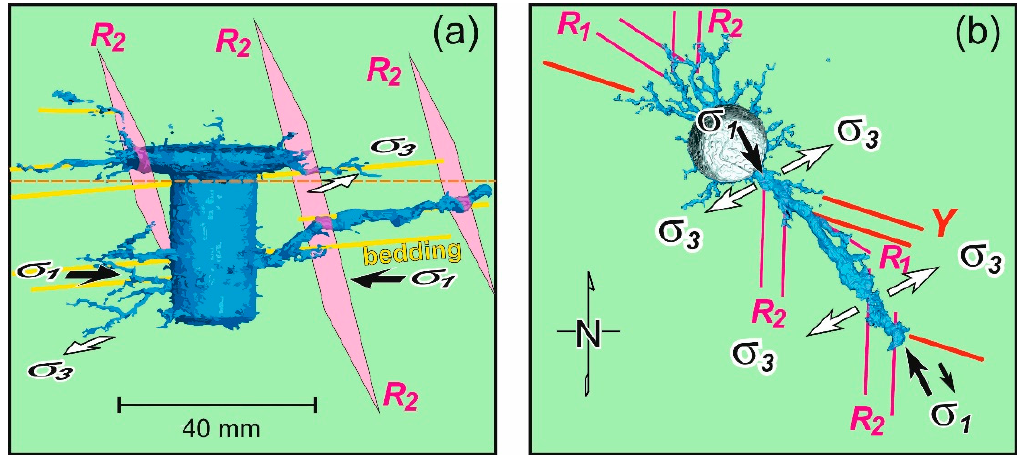
Figure 9. Results of structural interpretation of dissolution network/wormhole morphology for experiment #9 (12 h of CO 2 -rich solution injection into sample): ( a ) 3D model and ( b ) top view of the 3D model after CT inspection, horizontally cut at the level of the orange dashed line within inset ( a ).